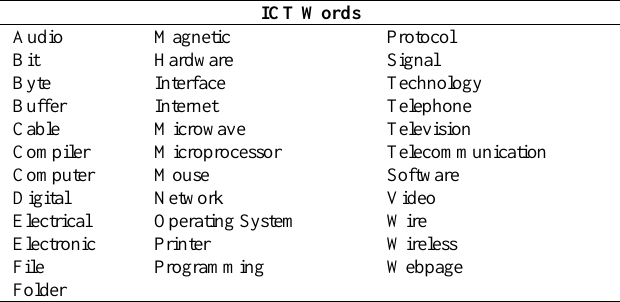
Table 4. Selected words in ICT